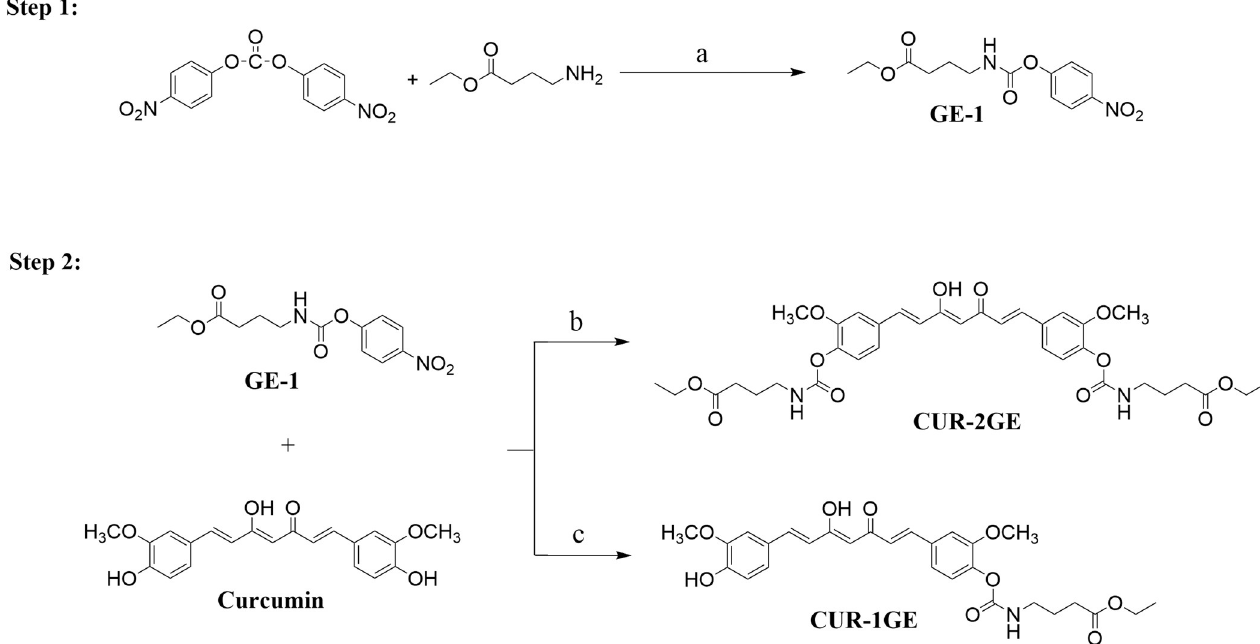
Fig 1. Synthesis of CUR-2GE and CUR-1GE. Reagents and condition (a) DMAP/ACN 50˚C 3 h (b) DMAP/ACN 50˚C 24 h with GE-1: curcumin at molar ratio 4.5: 1 (c) DMAP/ACN 50˚C 24 h with GE-1: curcumin at molar ratio 1: